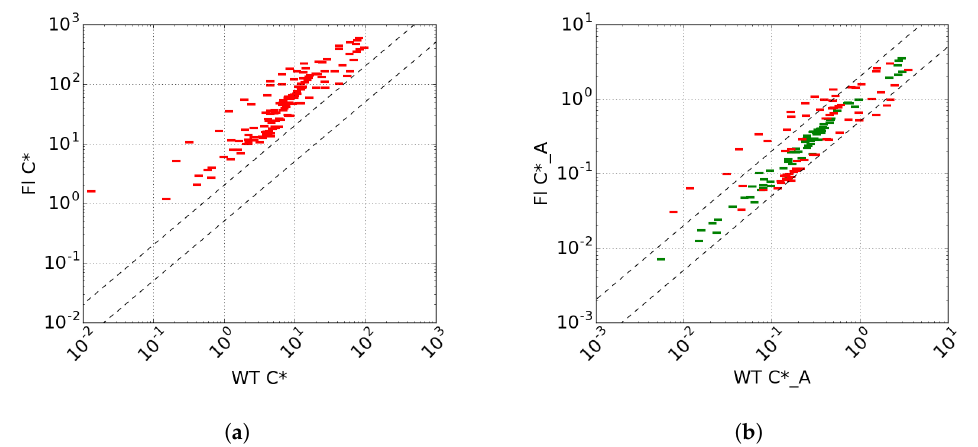
Figure 8. Scatter plots of ( a ) C ∗ and ( b ) C ∗ for the wind tunnel and LES. Green markers indicate A values which meet the criteria, red markers indicate values which do not meet the criteria. Dotted line is the x = y line, dashed lines are the factor 2